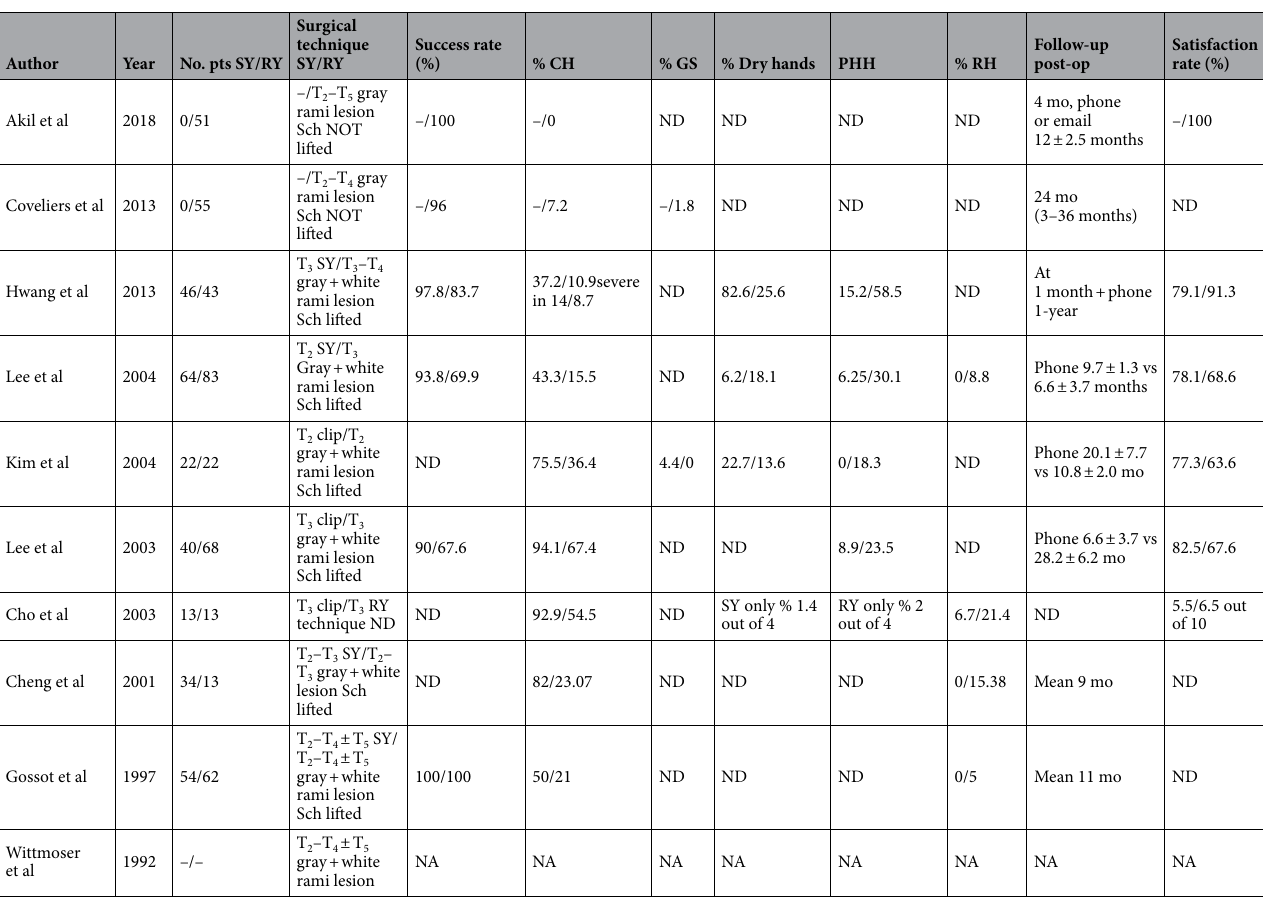
Table 4. Summary of the studies on endoscopic thoracic RY over the years. Sympathicotomy (SY). Ramicotomy (RY). Sch (Sch) Compensatory sweating (CH). Gustatory sweating (GS). Persistent hand humidity (PHH). Recurrence hyperhidrosis (RH). Not described (ND). Phone (follow-up performed through a telephone